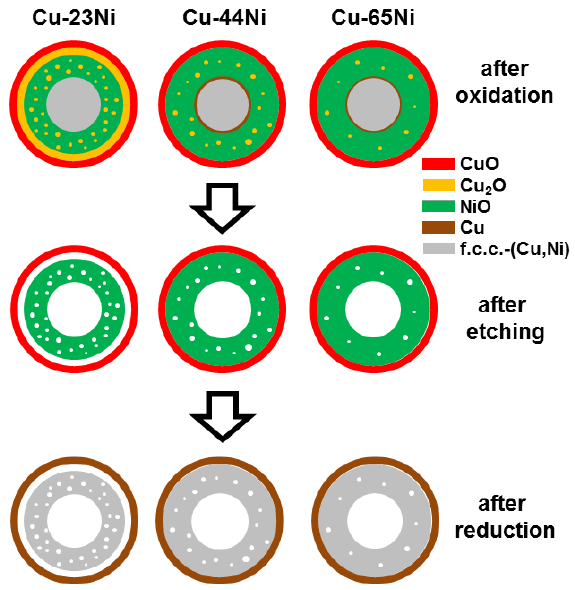
Figure 9. Scheme of the cross section of the partially oxidized wires (top), the oxide microtubes after chemical etching (middle) and metallic microtubes obtained after reduction under hydrogen atmosphere (bottom). Legend of the phases: CuO (red), Cu 2 O (yellow), NiO (green), Cu (brown), and f.c.c.-(Cu,Ni) (grey).